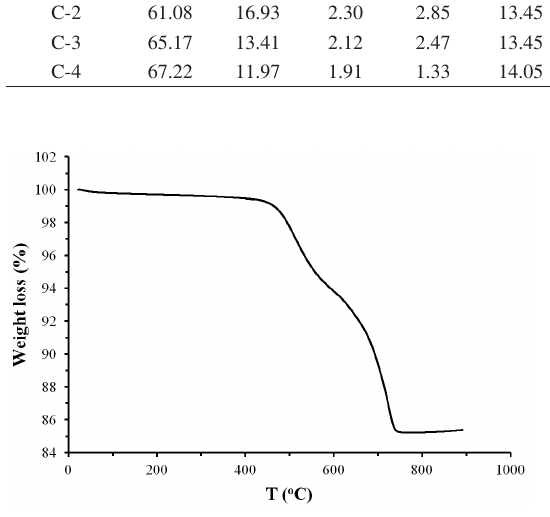
Figure 1. Thermogram (TGA) of composition C-1.